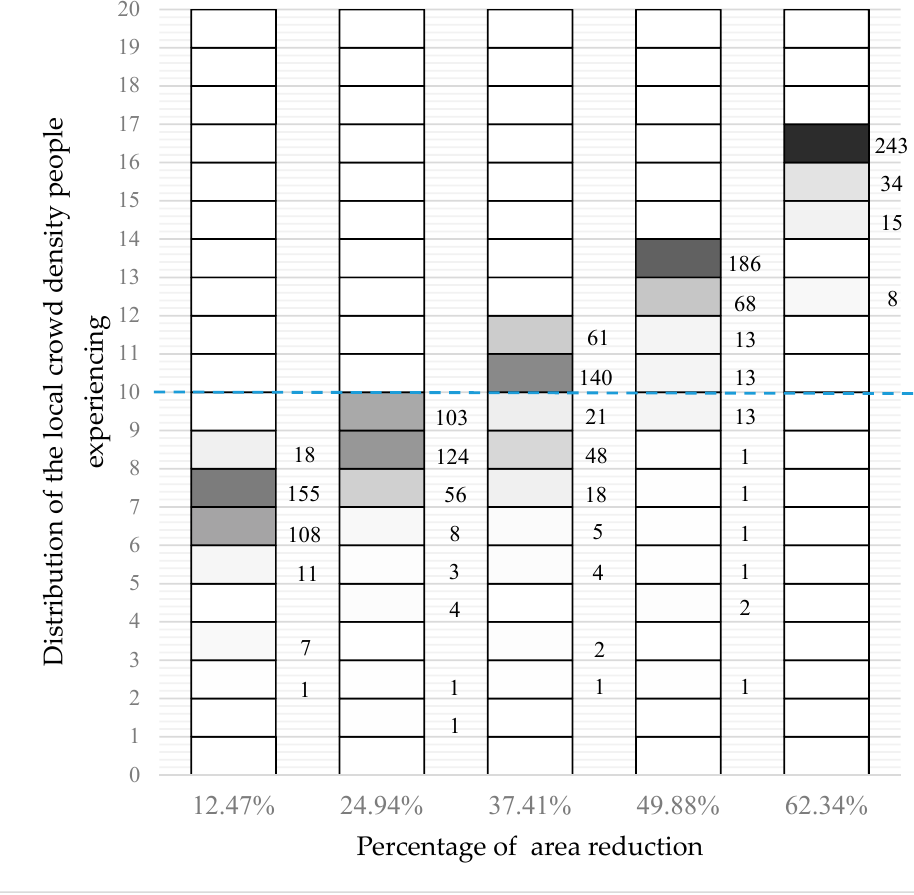
Figure 9. The distribution of local density that 300 agents experience when the lower wall moves by 0.5 m, 1.0 m, 1.5 m, 2.0 m, and 2.5 m to compress the occupied